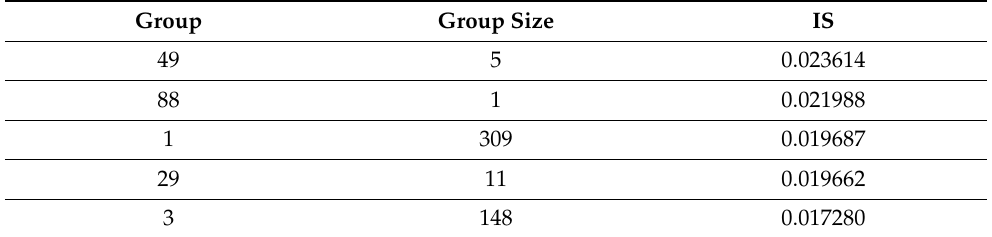
Table 7. ERA-Interim variable groups with top 5 importance scores. The values of group number (group), the number of variables in the group (group size), and the importance score (IS) are given. Group Group Size IS 49 5 0.023614 88 1 0.021988 1 309 0.019687 29 11 0.019662 3 148